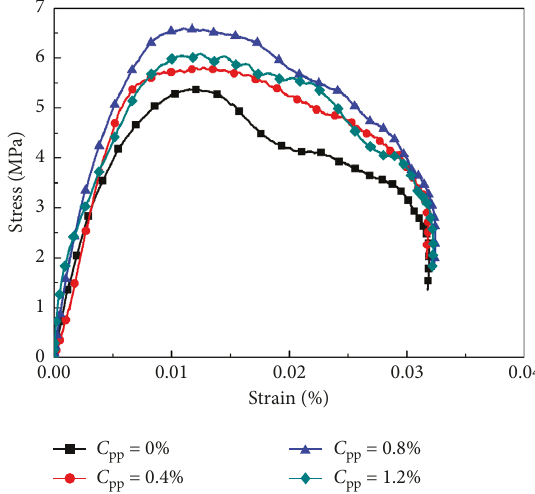
Figure 3: Dynamic stress-strain curves of polypropylene fiber- reinforced cement